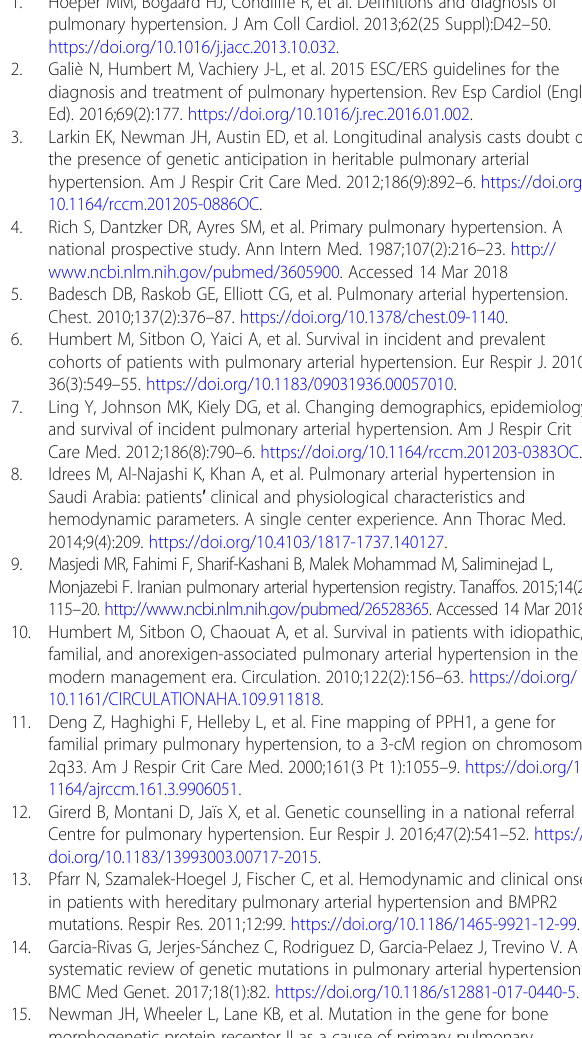
Additional file 1: Table S1. Highly suspicious compound mutations per patient linked to PAH molecular pathways. (PDF 670 kb) Additional file 2: Figure S1. Pedigrees for families showing no BMPR2 mutations. Square, Male; Circle, female; open symbol, unaffected; filled symbol, affected; symbol with diagonal line, dead individual. (PDF 752 kb) Abbreviations AUBMC: American University of Beirut Medical Center; BMPR2 : Bone morphpgenetic protein 2; CHD: Congenital Heart Disease; GDF2: Growth differentiation factor 2; MENA: Middle-East and North Africa; NGS: Next generation sequencing; NYHA: New York Heart Association; PAH: